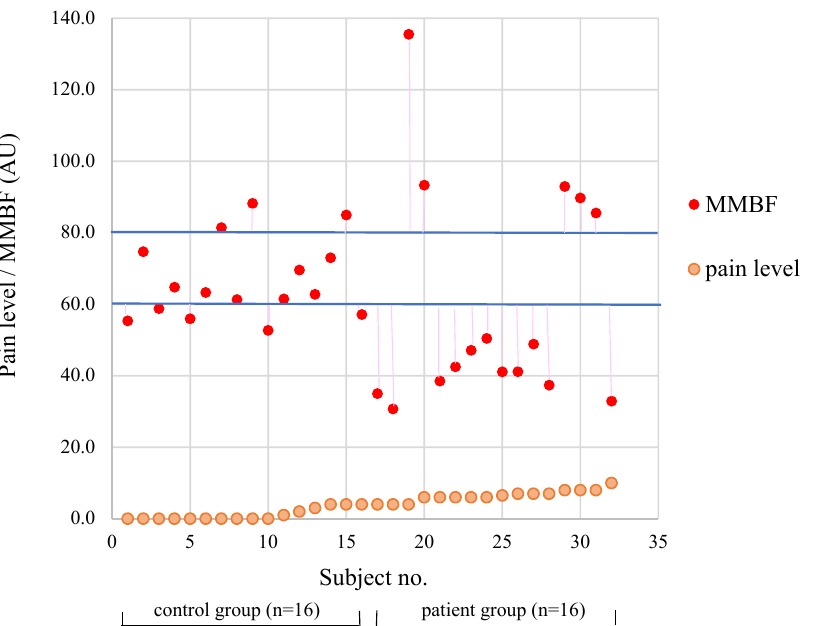
Figure 2. Distributions of pain level and shoulder mean microcirculatory blood flow (MMBF) in the subjects ( n = 32).